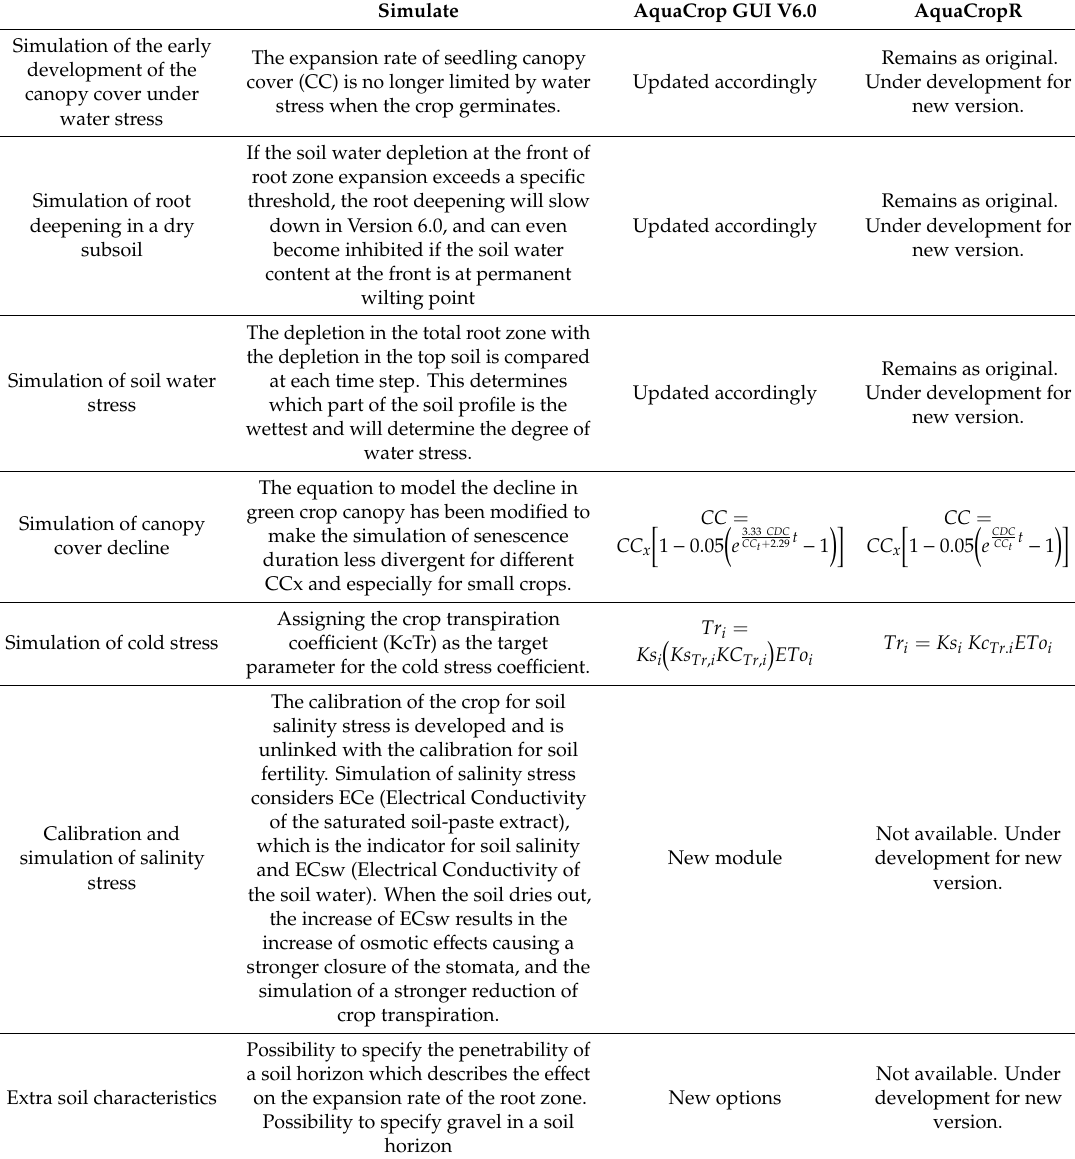
Table 2. Di ff erences between AquaCrop GUI and